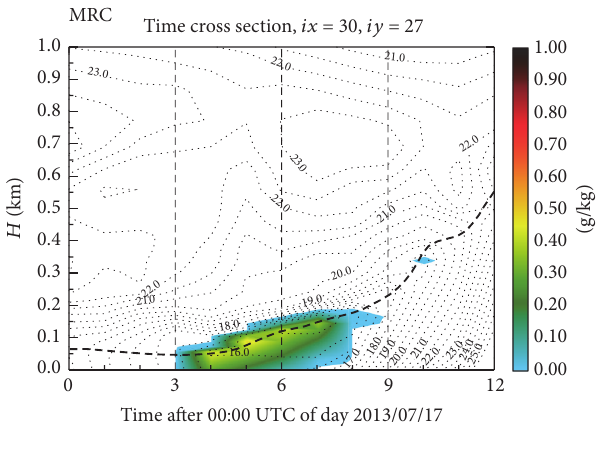
Figure 15: Temporal evolution (18/07/2013 from 00 to 12 UTC) of simulated air temperature (lines in ∘ C) and liquid water mixing ratio (color scale in g/kg) over the Beja Air Base nearest grid point of D2 domain. Fog > 0.05 g/kg liquid water mixing ratio (Introduction chapter).